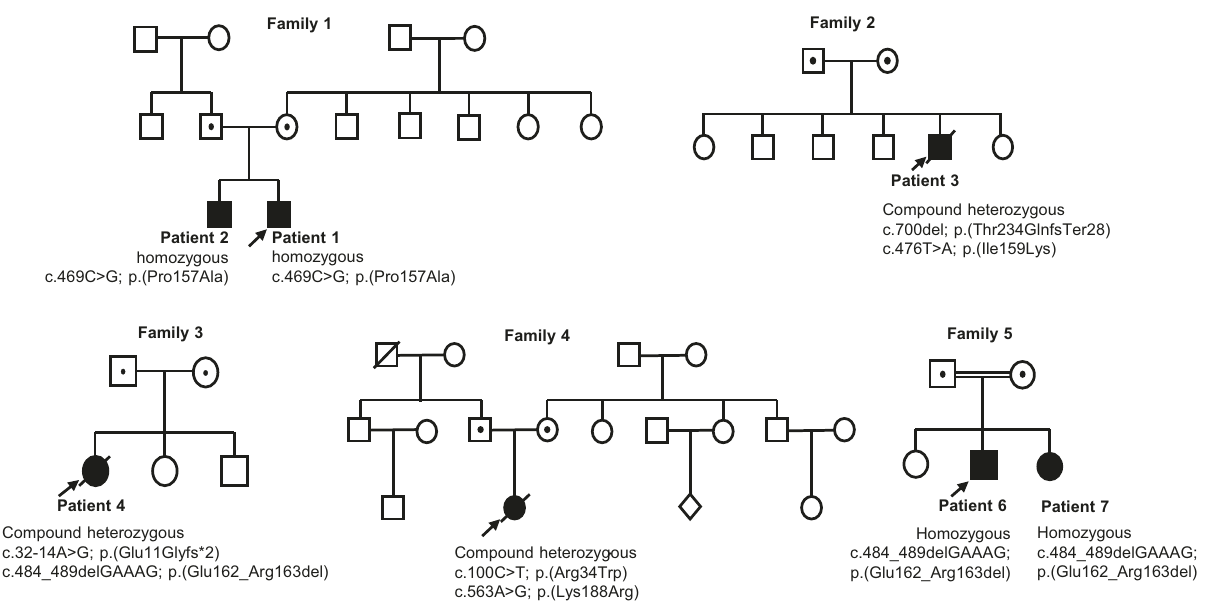
Fig. 1 | Pedigrees. Pedigrees of the fi ve families with associated TEFM